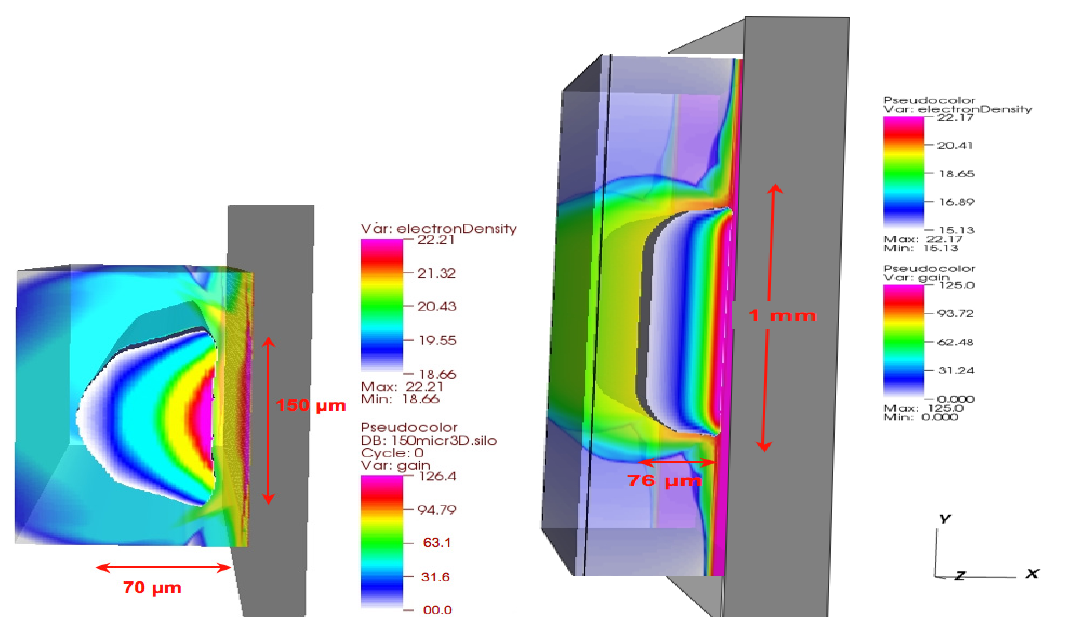
Figure 2. Image in false colors of plasmas created by 100 µm ( left ) and 1 mm ( right ) focal width. For 1 mm large width, the plasma flow along the target surface is very